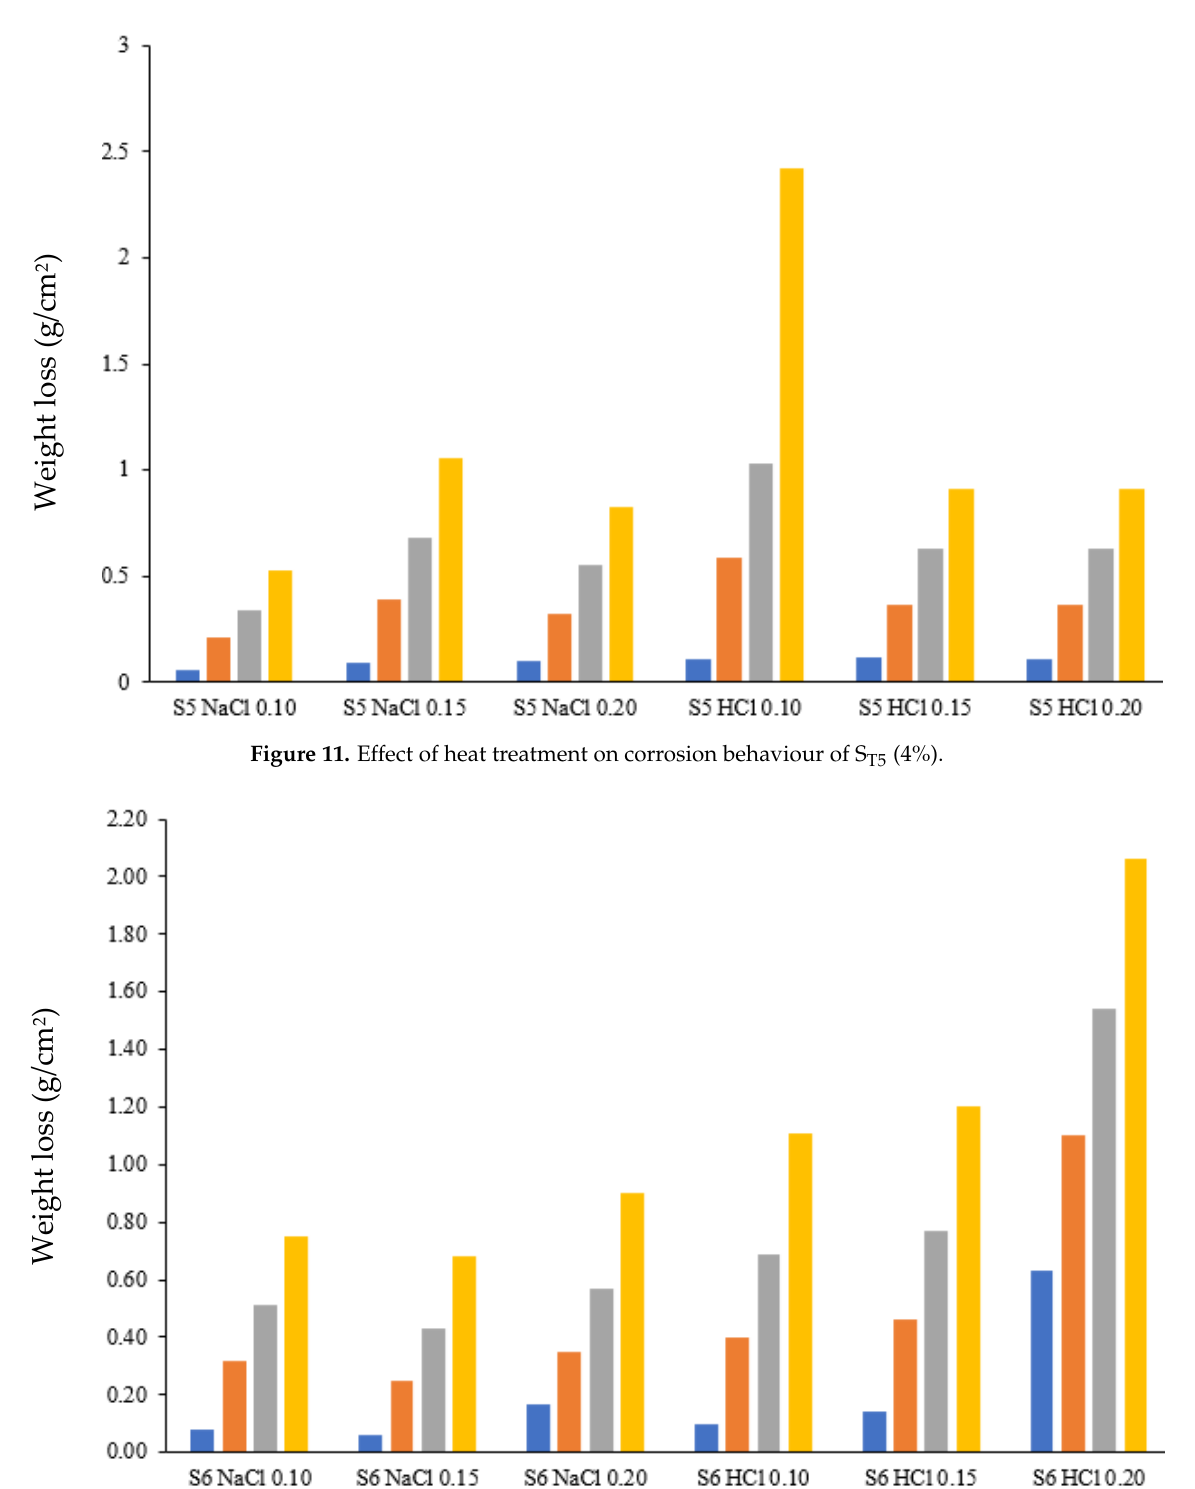
Figure 12. Effect of heat treatment on corrosion behaviour of S T6 (6%). Table 10. Specimen S T4, S T5 and S T6 weight reduction in HCl and NaCl.